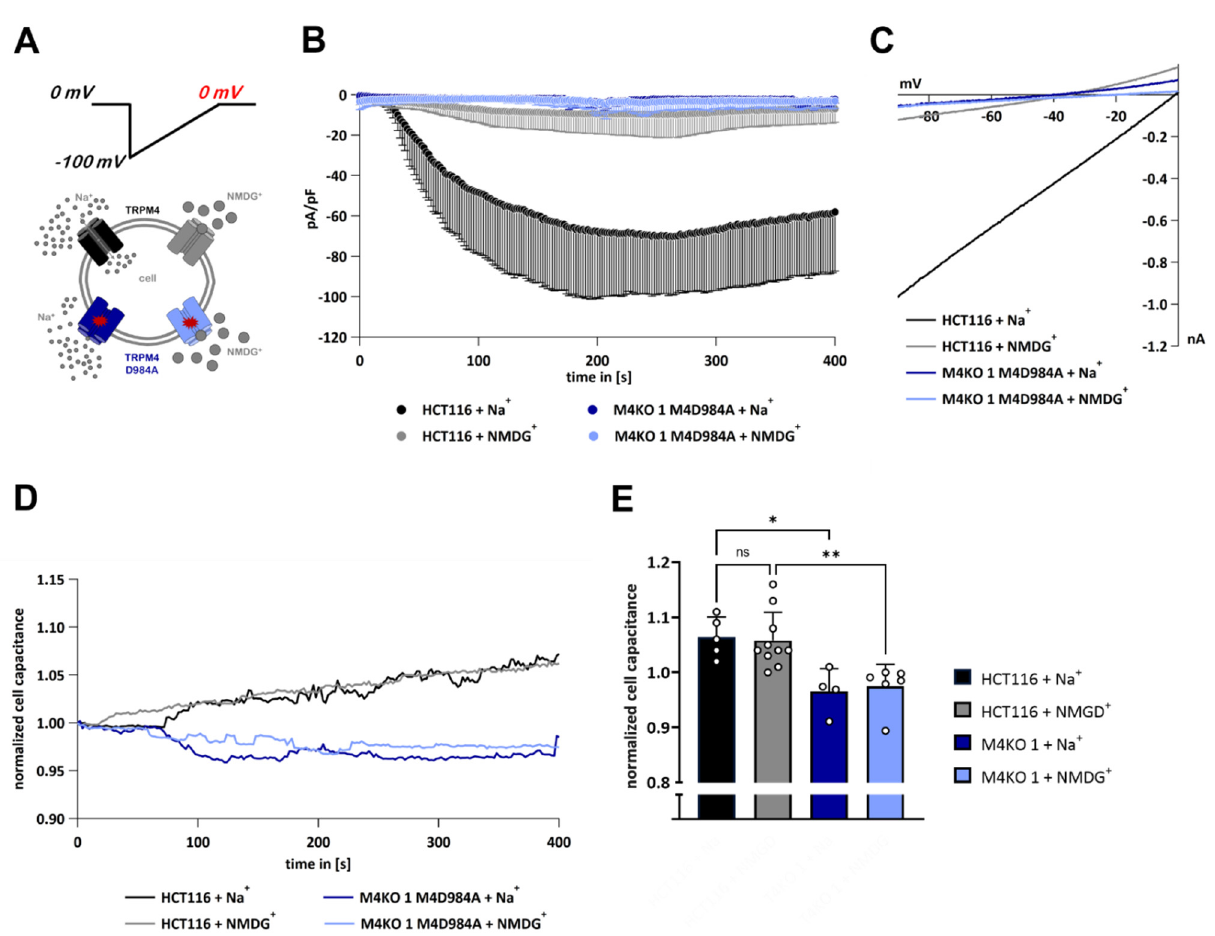
Figure 6. “Half-ramp” experiments in HCT116 and M4KO 1 cells. ( A ) Graphical representation of the experiment. Voltage ramps spanning from − 100 to 0 mV were delivered from a holding potential of 0 mV; under these conditions, only an inward TRPM4 current occurred (upper panel). HCT116 cells endogenously expressing TRPM4 or M4KO 1 expressing M4D984 were used, and either Na + or NMDG + were present in the bath solution, to allow for or to prevent inward currents (lower panel). ( B ) I CAN was evoked with 10 μ M Ca 2+ in the pipette ( n = 5 for HCT116 + Na + , n = 10 for HCT116 + NMGD + , n = 4 for M4KO 1 M4D984A + Na + , and n = 6 for M4KO 1 M4D984A + NMDG + ). ( C ) Corresponding IVs at 394 s from cells in ( B ). ( D ) Scatter plot and normalized cell capacitance plotted versus time from cells in ( B ). ( E ) Scatter plot and bar diagram of data (mean + SD) at 394 s from ( D ). Kruskal–Wallis test for non-parametric data was used to determine statistical significance (* p < 0.05, ** p < 0.01, and non-significant (ns)).